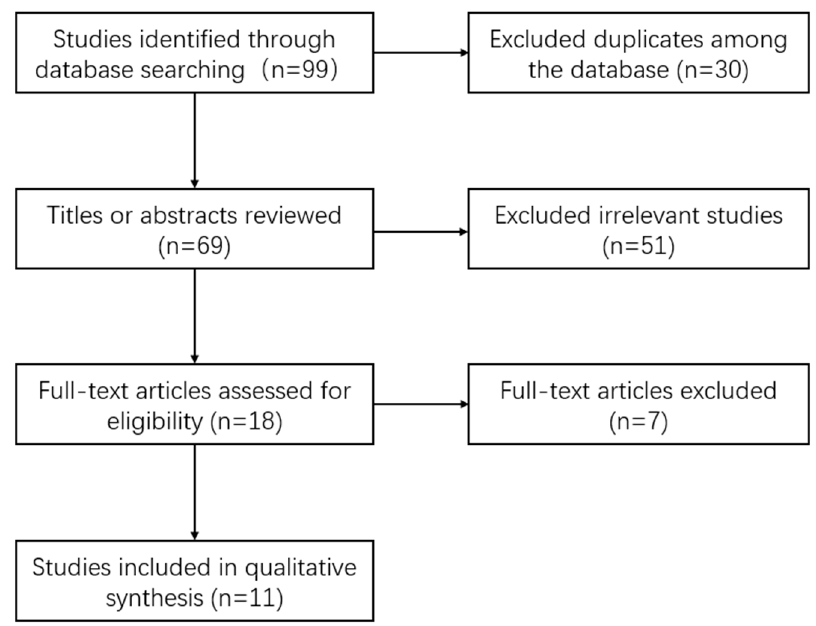
Figure 1. The selection process of this comprehensive research review.